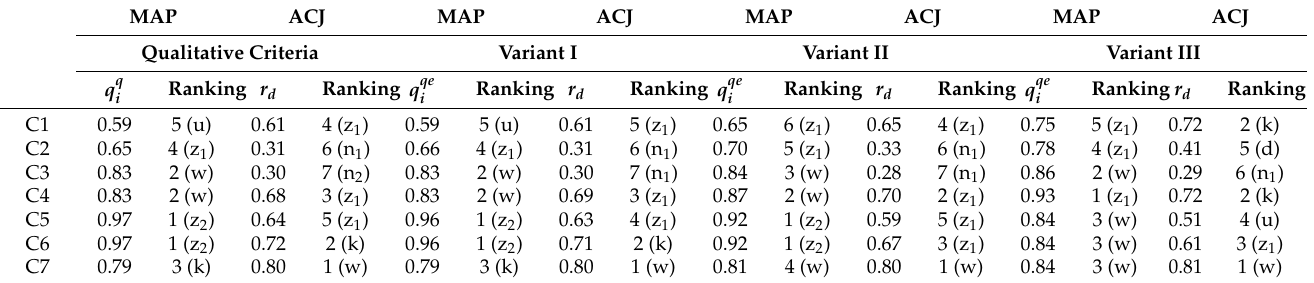
Table 7. Comparison of results for MAP method and ACJ method for quality and qualitative– environmental